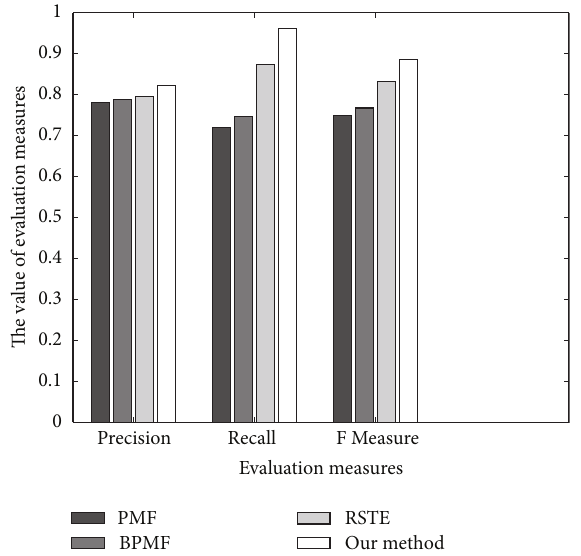
Figure 6: Comparison of evaluation measures for different methods on Epinions